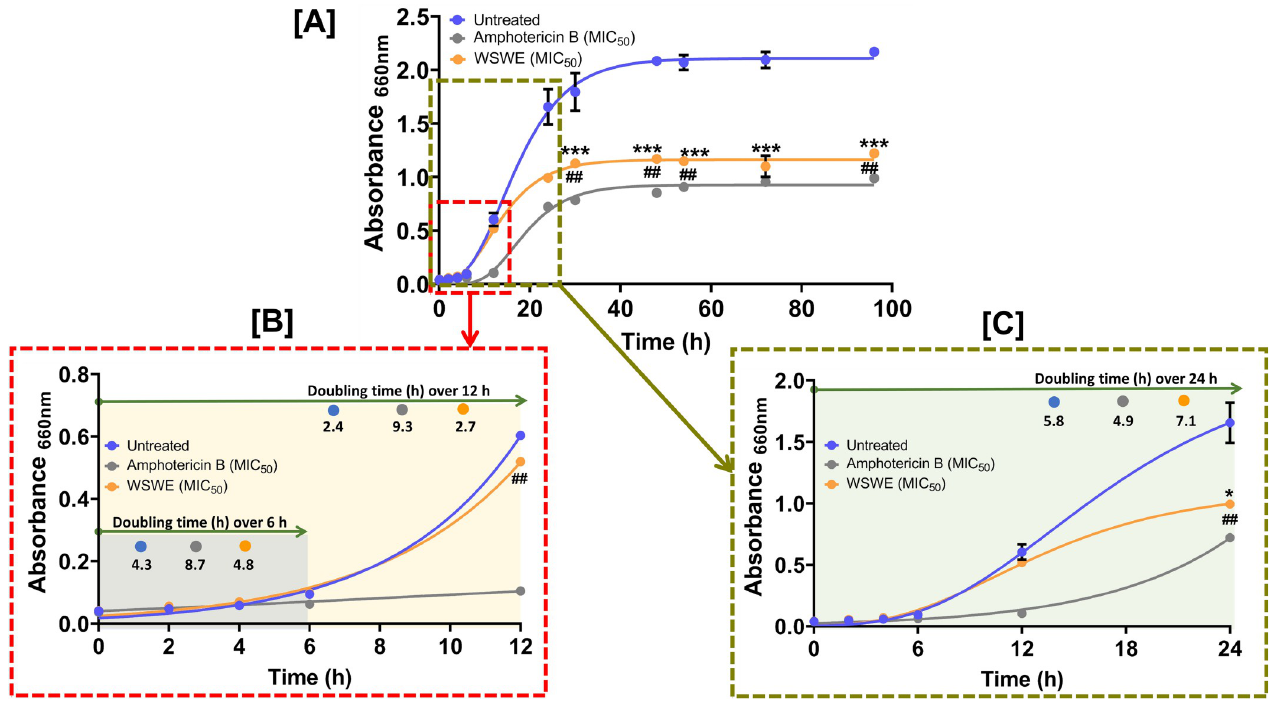
Fig 3. Time kill kinetics of WSWE against S . globosa . [A] Time-kill curve over 96 h growth of untreated and amphotericin B/WSWE treated S . globosa cells, obtained through non-linear regression fitting to Gompertz function, showing the inhibitory kinetics of the treatments. [B, C] Gompertz function fitted time- kill curves over initial 12 (B) and 24 (C) h of growth, depicting the changes observed in the growth kinetics owing to treatments. The doubling times of the different populations of S . globosa cells were determined through Malthusian regression. Each time point represented mean ± SEM of duplicate readings. Statistical significance was determined through 2-way analysis of variance (2-way ANOVA) and represented as � and ��� for p < 0.05 and 0.001, respectively when comparison was with untreated group, whereas, the comparison with amphotericin B treated group was denoted as ## for p < 0.01.